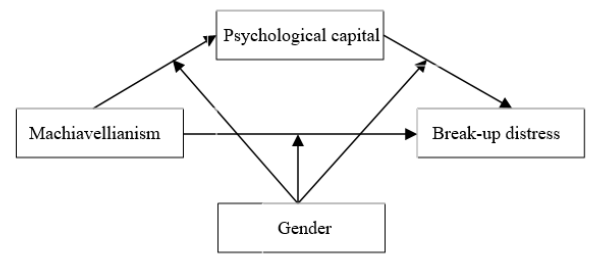
Figure 1. The hypothetical theoretical model.